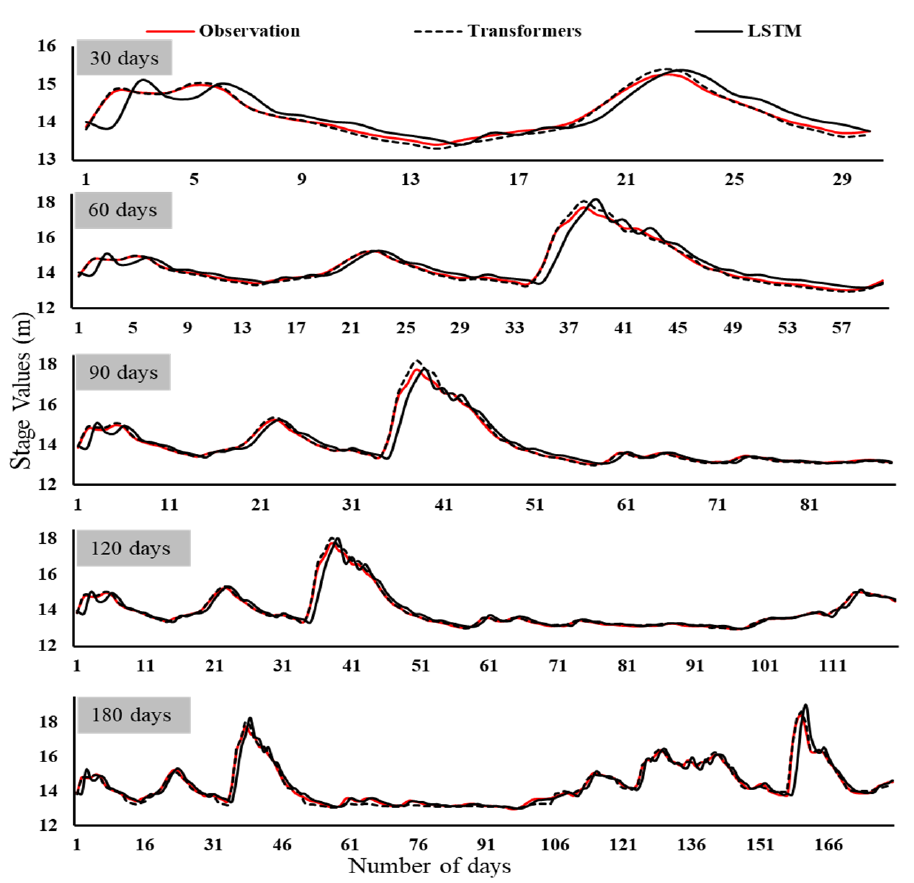
Figure 4. Outcomes of the DL models vs. different future forecasted stage data for Chattahoochee station.